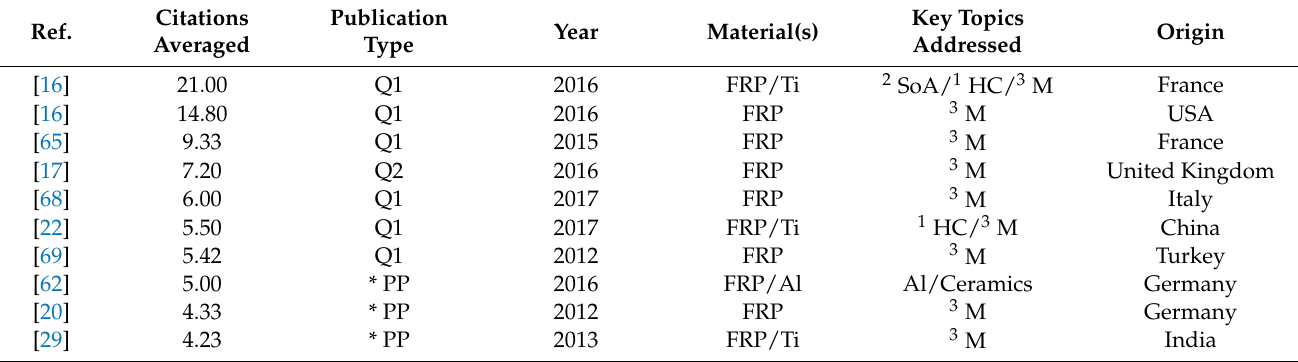
Table 6. Summary of studies including FRP, listed by the average number of citations, taking into account the number of years the article has been